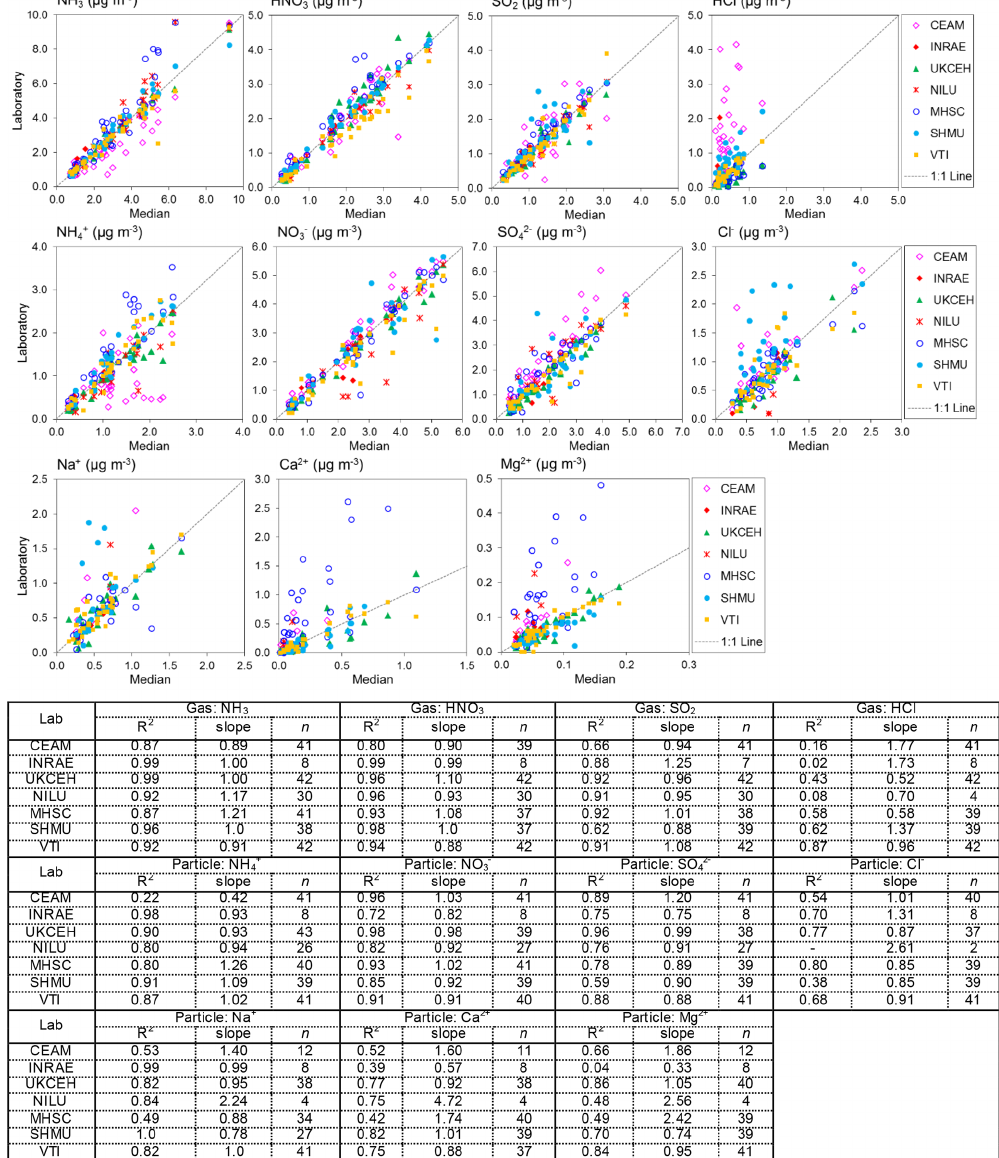
Figure 6. Scatterplots comparing atmospheric gas (NH 3 , HNO 3 , SO 2 , and HCl) and aerosol (NH + concentrations measured by each of the NEU laboratories with the median estimate of all laboratories. Data from all field inter-comparisons (2006–2009) for all test sites (Auchencorth, UK; Braunschweig, Germany; Montelibretti, Italy; and Paterna, Spain) are combined in the analysis. A summary of the regression results is shown in the table below the graphs. Note that (i) there are fewer data points for INRAE because they joined the NEU network later in 2007 and participated in the 2008 and 2009 inter-comparisons only, and (ii) the low number of observations in some cases was due to some laboratories not reporting all parameters. NILU: HCl, Cl − , Na + , Ca 2 + , and Mg 2 + reported for 2008 inter-comparisons only; CEAM: Na + , Ca 2 + , Mg 2 + reported for 2007–2009 inter-comparisons